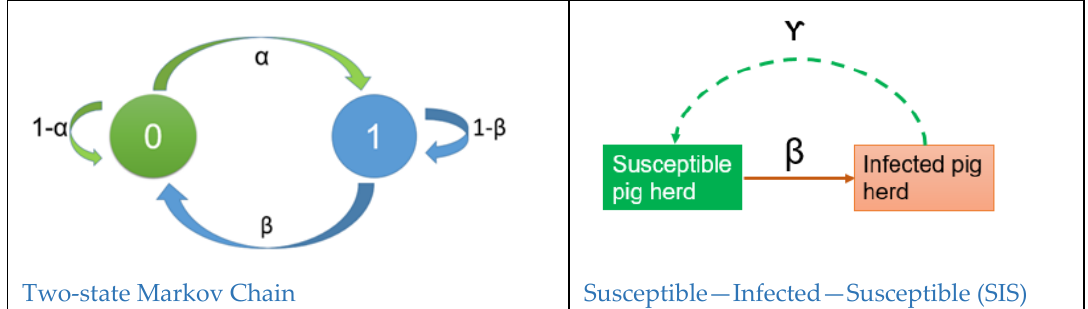
Figure 2. On the left, the diagram shows transition states of Norwegian pig herds in a two-state discrete-time Markov chain since 2009. In the first state (2009), a pig herd either existed as either uninfected (0) or infected (1). In the next time state, the uninfected herd could shift to the new state of infected with a probability α or remain in its uninfected status quo with a probability of 1 − α . Similarly, the infected herd could recover to an uninfected state in the next time step with a probability of β or remain infected with a probability of 1 − β . The transition probabilities satisfy the condition 0 < α , β < 1. Quite similar to the Markov model is another compartmental model, the SIS model. Parameters of the SIS model are infection rate ( β ) and recovery rate